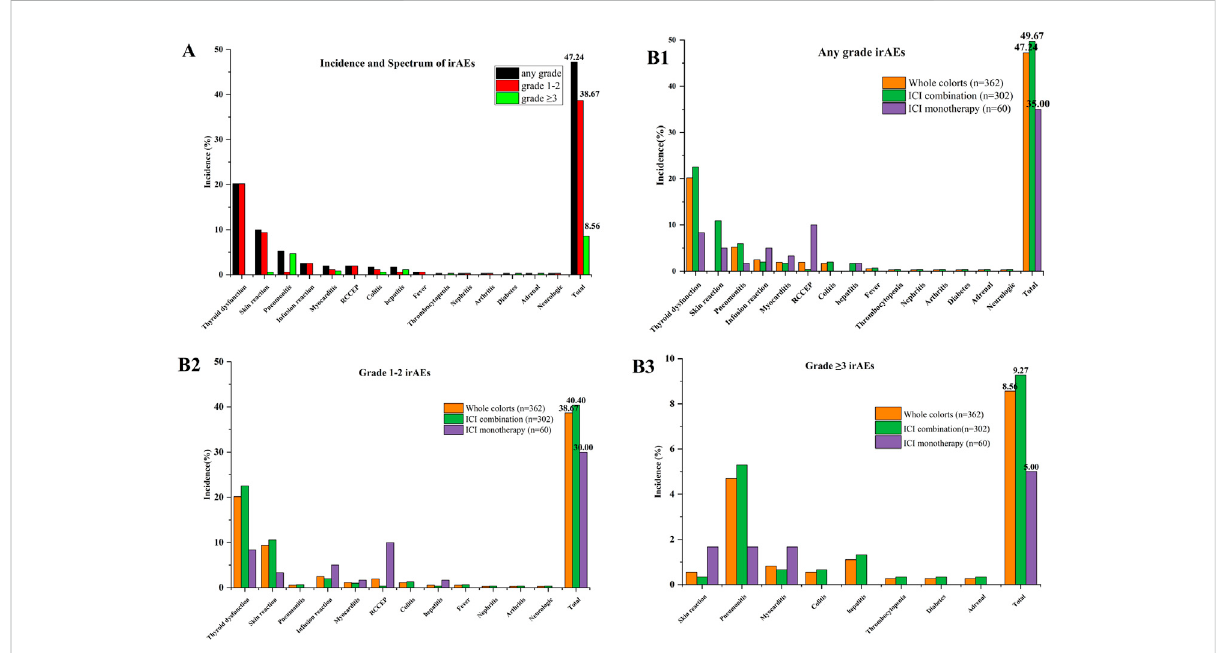
FIGURE 1 Incidence and spectrum of irAEs between immune checkpoint inhibitor monotherapy and combination: (A) Incidence and spectrum of irAEs; (B1 – 3) irAEs between immune checkpoint inhibitor monotherapy and combination. ICI combination: combination with chemotherapy, anti- vascular drug, anti-vascular and